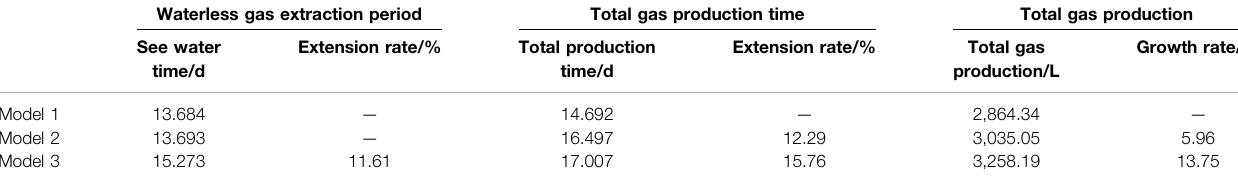
TABLE 4 | Quantitative comparison statistics of simulation results from different models.